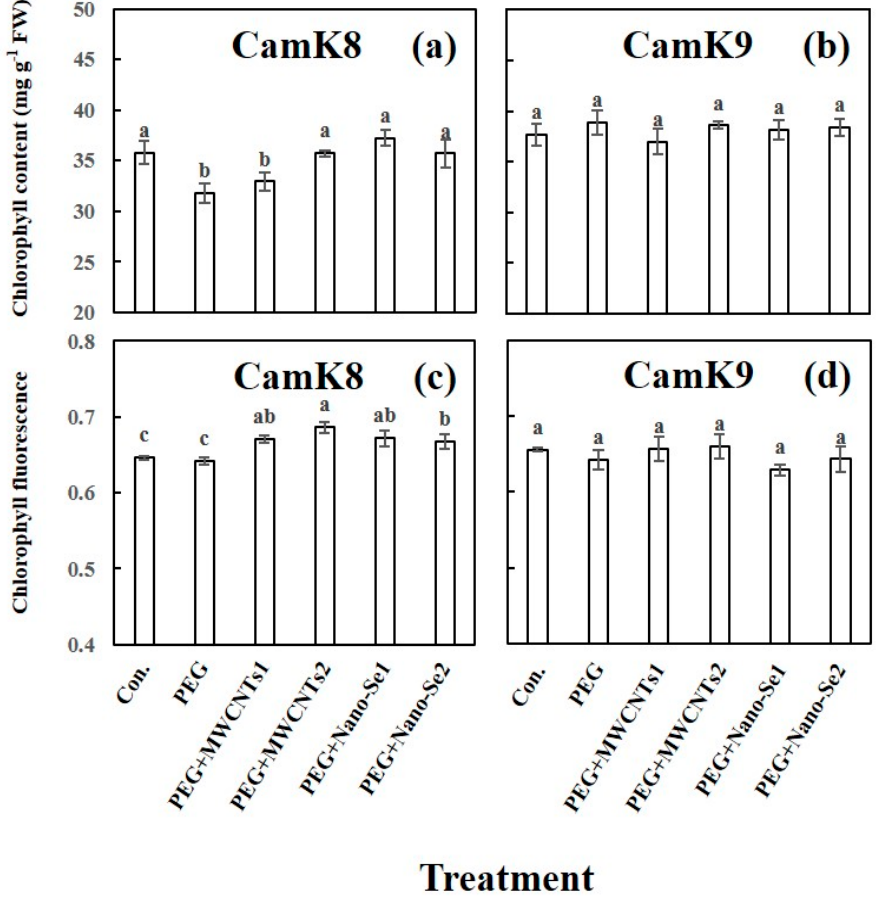
Figure 2. Effect of various treatments on the chlorophyll content (mg g − 1 ) ( a , b ) and F v /F m ( c , d ) of CamK8 ( a , c ) and CamK9 ( b , d ) under PEG-induced WDS at the third day after treatment. Con.: un–treated control; PEG + MWCNTs 1 or 2: foliar application of MWCNTs with dose 1 (50 mg L − 1 ) or 2 (100 mg L − 1 ) following root application of PEG solution concentration (19.0 mM); PEG + nano-Se 1 or 2: foliar application of nano-Se with dose 1 (5 mg L − 1 ) or 2 (10 mg L − 1 ) following root application of PEG solution concentration (19.0 mM). Values are means ( n = 3) and bars denote the standard error of the mean. Different letters represent the significant different values determined by the Tukey post hoc test ( p ≤ 0.05).